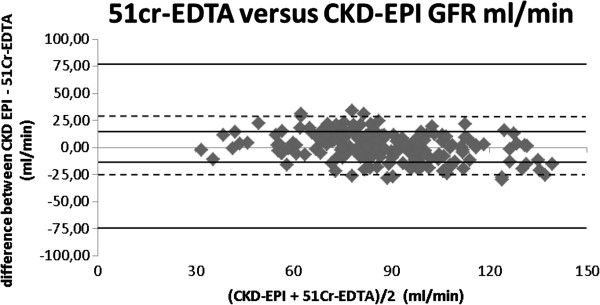
Bland altman plot 51cr-EDTA versus CKD-EPI formula. 51cr-EDTA: 51 chromium ethylene diamine tretraacetic acid clearance; CKD-EPI: Chronic kidney disease epidemiology collaboration.